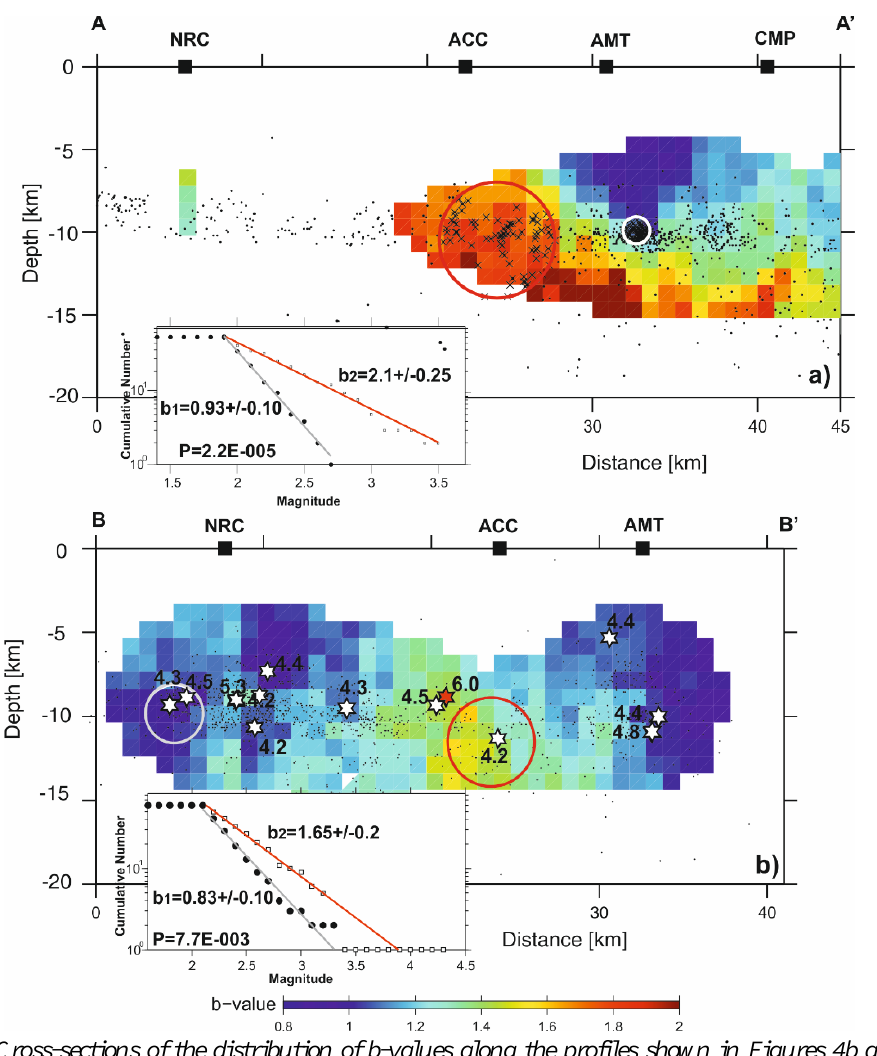
Figure 5. Cross-sections of the distribution of b-values along the profiles shown in Figures 4b and 4c. (a) AA' cross-section. (b) BB’ cross-section. The red and grey circles represent the volumes of high and low b- values used to calculate the FMDs. The white stars represent the aftershocks occurred during the Amatrice sequence. The red star is related to the 2016 Amatrice